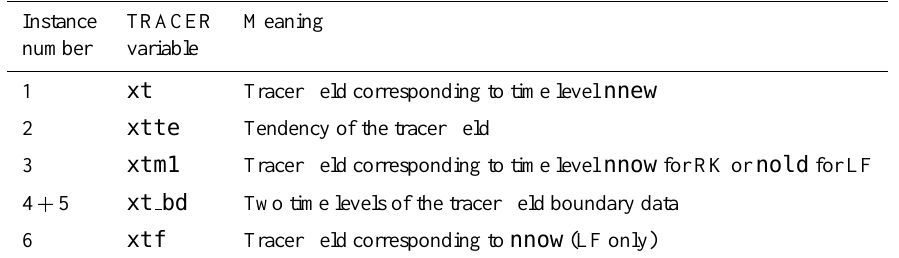
Table 1. Definition of tracer field instances in COSMO/MESSy. The middle column lists the variable names of the respective fields in TRACER. The abbreviations RK and LF denote the Runge-Kutta and Leap-frog scheme,